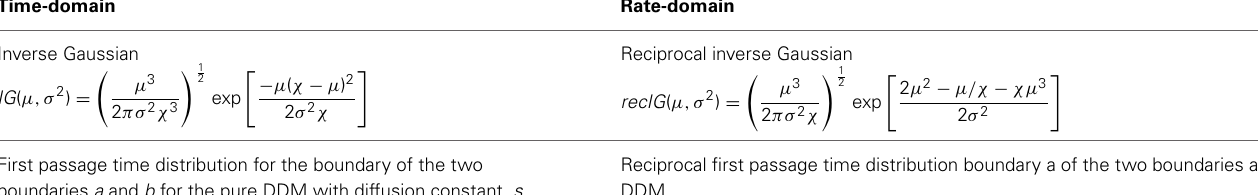
Table 1 | Left column: mathematical expressions of the probability density functions (pdf’s) for RTs for a single boundary diffusion model, two boundary diffusion model, and the reciprocal Normal.